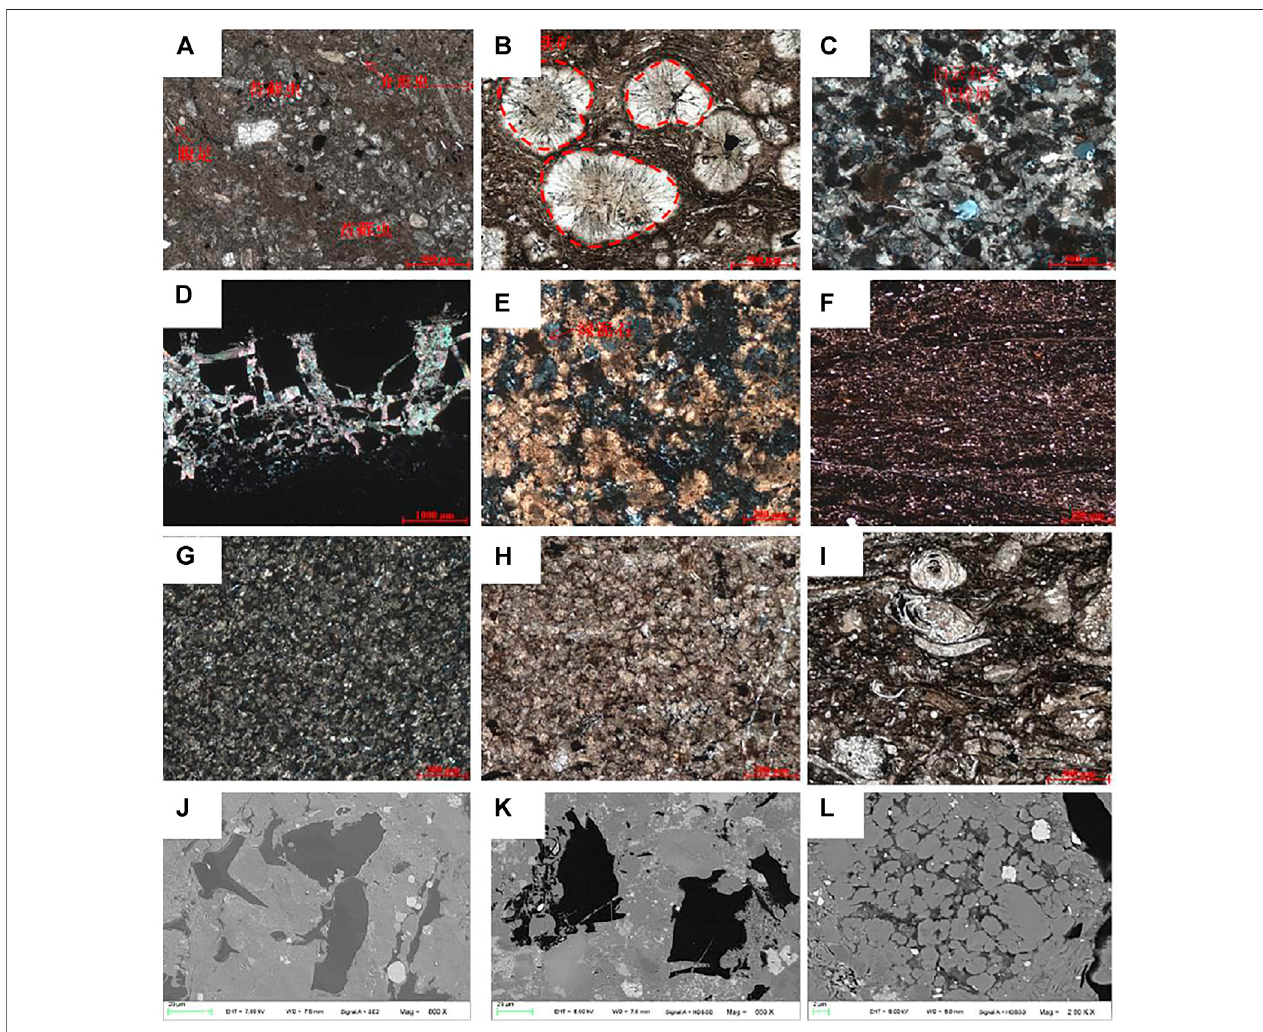
FIGURE 4 | Thin section identi fi cation and SEM observation results of the Longtan Formation reservoir in well X1. (A) Micritic dolomite containing bioclastic. (B) Sideritemudstone and siderite in anodularand sphericalshape, withradialstructure inside. (C) Dolomitic fi ne-grained lithic sandstone, withrock debrismostlyreplaced by dolomite. (D) Coal rock, with cracks fi lled with calcite. (E) Siderite rock, radial, with chlorite at the core. (F) Mudstone. (G) Dolomitic siderite rock, with siderite predominantly composed of fi ne microcrystalline granular aggregates; the whole body is granular and lumpy, mainly in the form of metasomatic dolomite minerals. (H) Finepowderysideriterock,mainlycomposedofsiderite,lightyellowishbrownasawhole,mostlyinsemi-idiomorphicgranularform. (I) Argillaceousclasticlimestone; some bryozoans are tubular and branched, and a few foraminifera are spindle-shaped, which are metasomatized by calcite and silica. (J) Fragmented and banded organicmatterisdistributedintensively. (K) Thegapbetweeneachmineralcomponentandthecrushedmassiveorganicmatterareinclosecontactwiththesurrounding mineral components. (L) Microcrystalline quartz (siliceous), clay minerals, and organic matter coexist with each other.